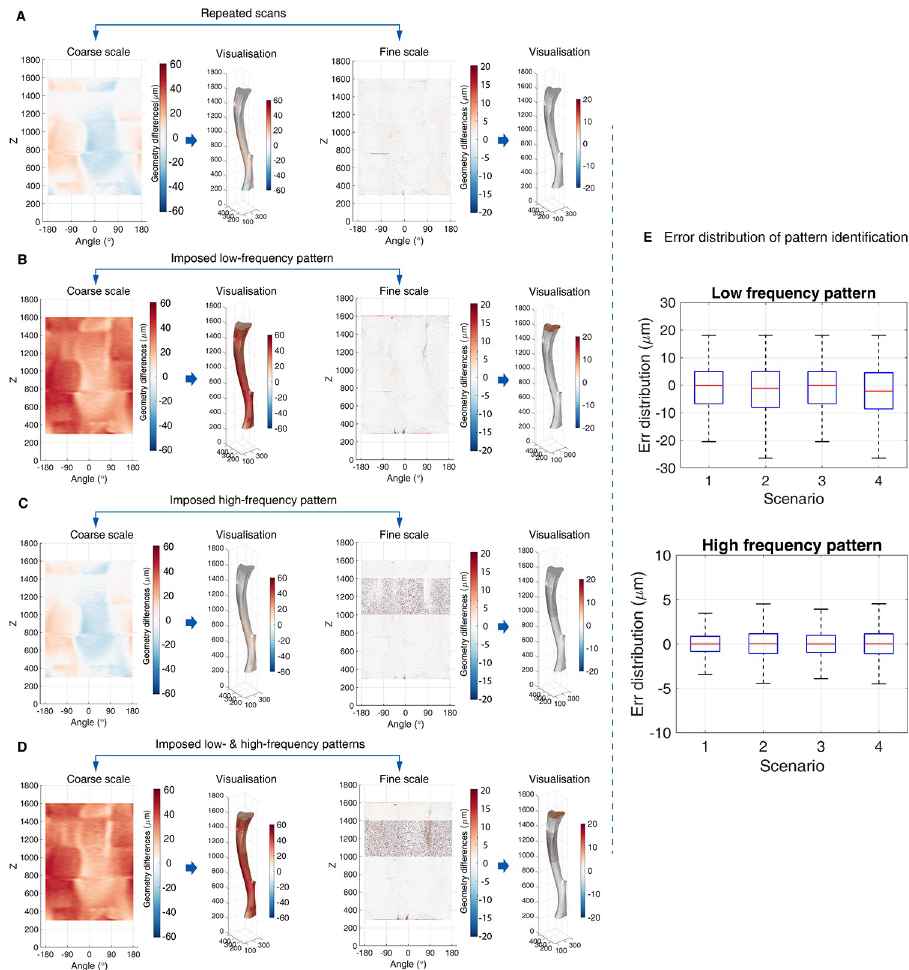
Fig 3. Evaluation of the algorithmic accuracy. (A) Multi-resolution analysis of the Scenario 1: zero low- and hight- spatial frequency activity. (B) Analysis of the Scenario 2: only imposed low-spatial frequency activity. (C) Analysis of the Scenario 3: only imposed high-spatial frequency activity. (D) Analysis of the Scenario 4: imposed low- and high- spatial frequency activity. In each figure, from left to right, they show the decomposed coarse scale of geometric changes at different scenarios, the corresponding visualisation, the fine scale patterns and the corresponding visualisation. (E) The box plot of error distributions at different scenarios. The red line in the middle indicates the median value, the top and bottom of the box are the 75% and 25% of the error distribution and the whiskers extend to the minimum and maximum values. In sub-figures (A-D), the colourmap is used to indicate the magnitude and direction of the geometric changes. The warm colour (positive value) corresponds to the outward-pointing normal direction of the bone surface while the cold colour (negative value) corresponds to the inward-pointing normal